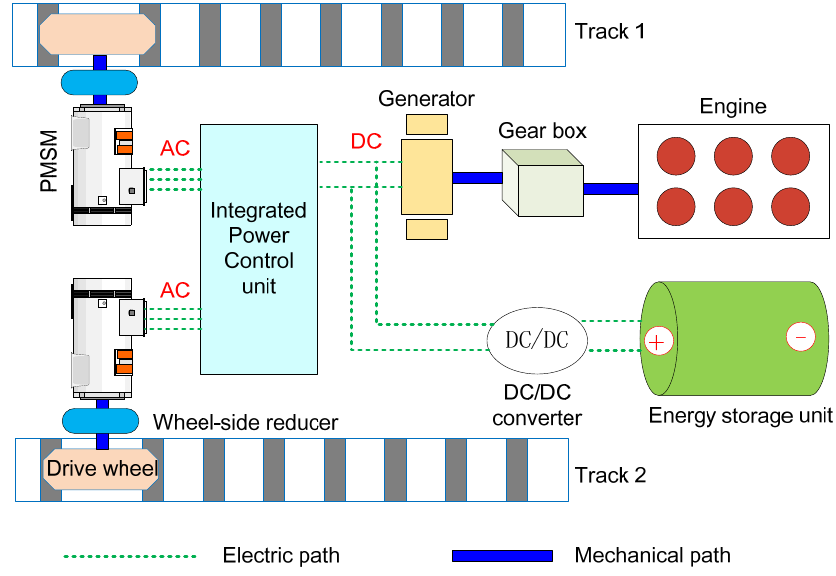
Figure 1. Schematic diagram of a DDTV structure.